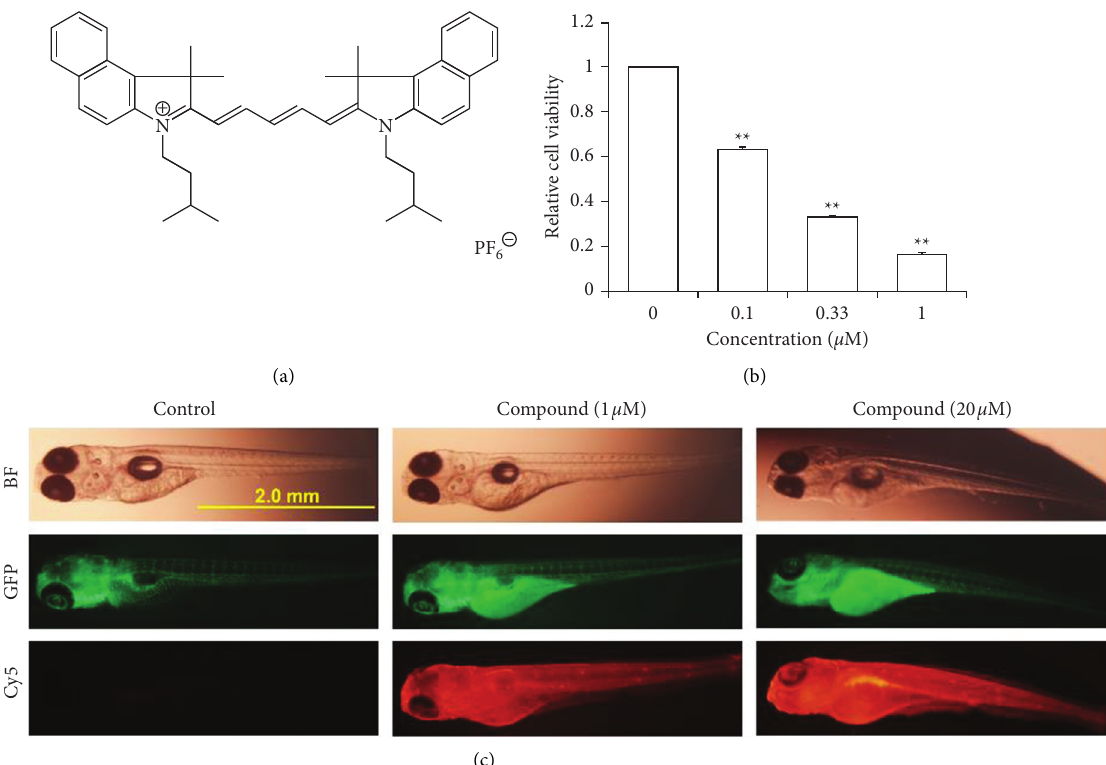
Figure 1: A novel fluorescent compound selectively inhibits cancer cell proliferation. (a) The chemical structure of the discovered novel fluorescent dye. (b) Cell proliferation status of K562 cells treated with the compound for 24h in different concentrations; ∗∗ P < 0 . 01 and n � 3. (c) Morphology phenotype of the 5 dpf (dpf, day postfertilization) zebrafish embryos observed under different (bright field, GFP filter, and Cy5 filter) microscopy filters after treatment with the compound in different concentrations from 3 dpf for 48h. There is no fluorescent signal detected under other available microscopy